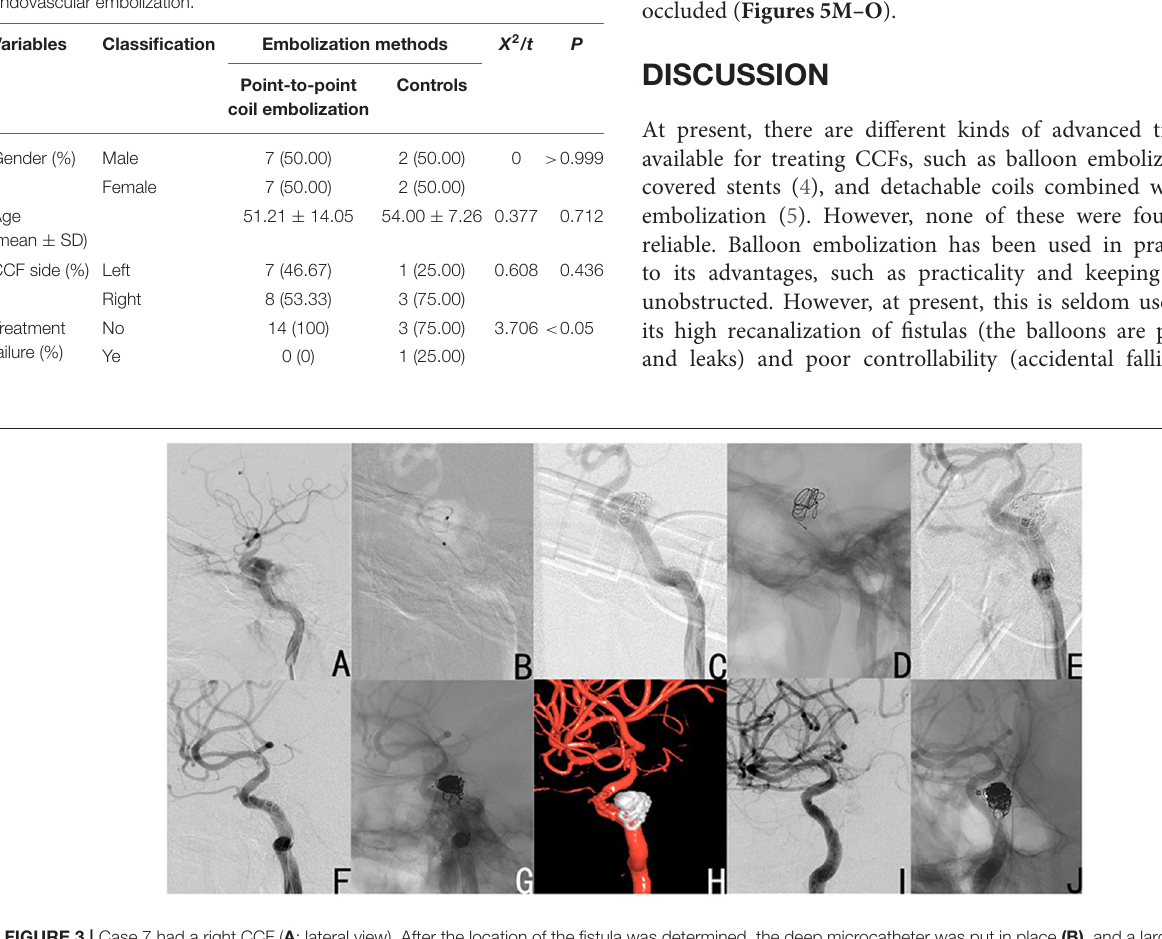
TABLE 3 | Clinical characteristics and outcomes of patients with direct CCFs, who underwent point-to-point coil embolization of the fistula or the combined endovascular embolization.